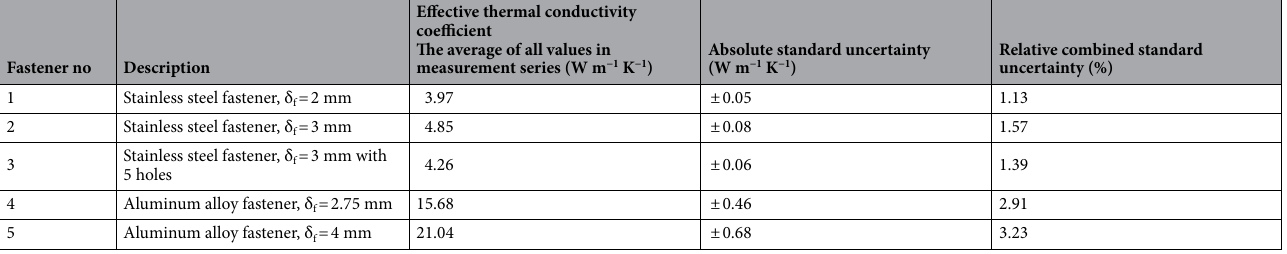
Table 3. Average effective thermal conductivity coefficient of the building fasteners.